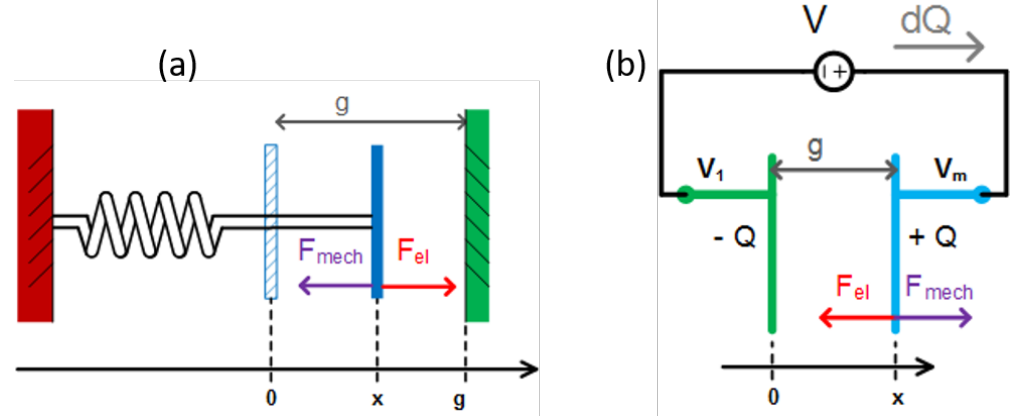
Figure 2. ( a ) Equilibrium on the moving mass considering an electrostatic force; and ( b ) the corresponding charge balance with a voltage biasing scheme.